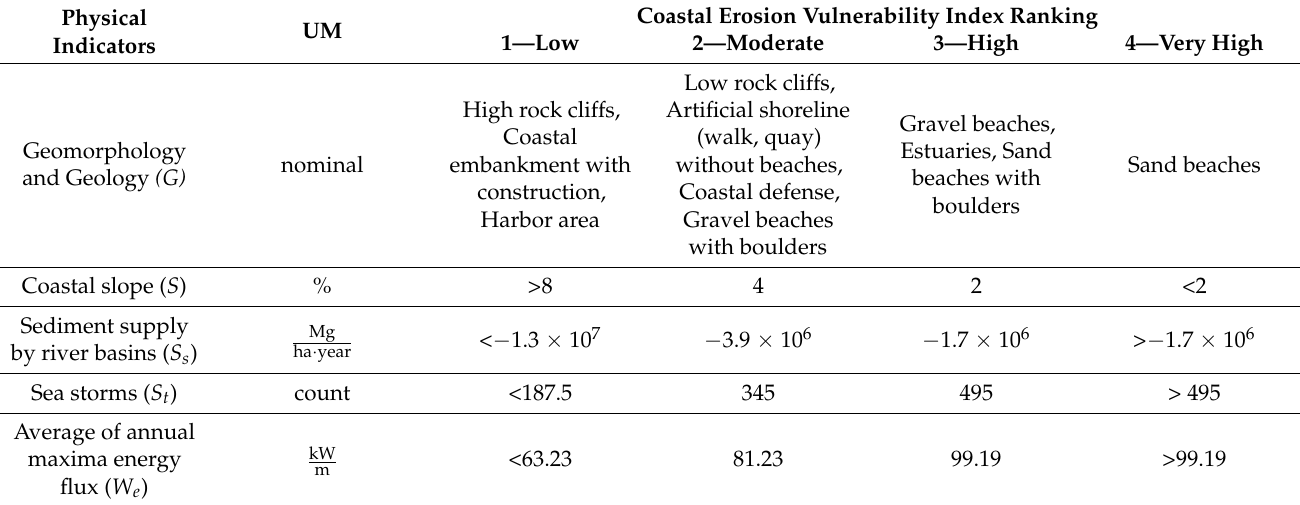
Table 3. Coastal vulnerability ranges for each physical indicator. UM—Unit of